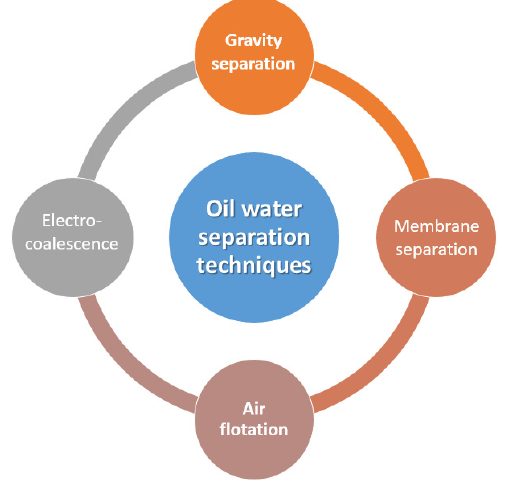
Figure 2. Principal oil/water separation techniques.